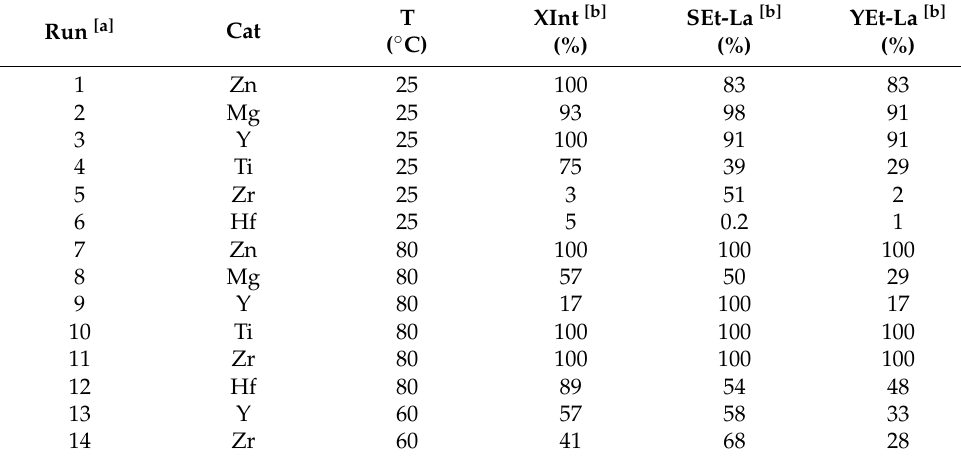
Table 2. Ethanolysis of PLLA using metal amides. Figure 2. 1 H NMR (CDCl 3 , 400 MHz) monitoring of PLA ethanolysis with assignment of internal (black), chain-end groups (blue and green), and ethyl lactate (red) alkyl protons.